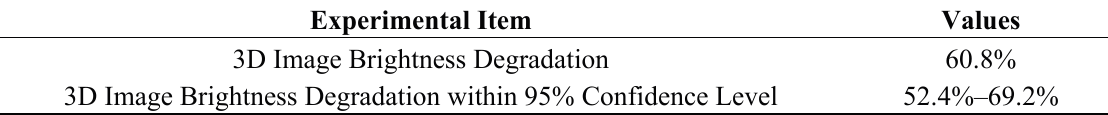
Table 9. Comparison of 2D and 3D image experimental